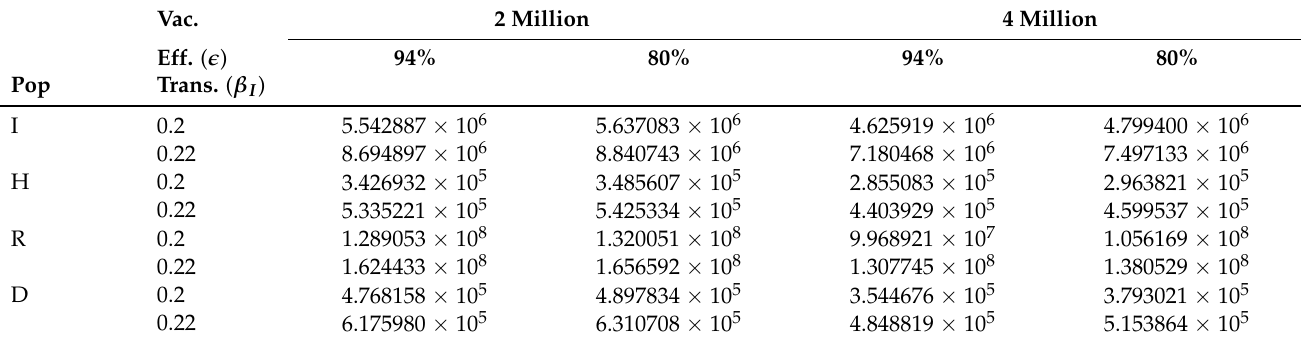
Table 5. Impact of the inoculation rate (Vac.) and the efficacy ( (cid:101) ) of the vaccine on the peak of the infected (I) and hospitalized (H) subpopulations. In addition, on the deaths (D) and recovered (R) cases. In these scenarios, the infectiousness of the asymptomatic individuals relative to symptomatic is 100% ( β A = β I ), and the percentage of infections that are asymptomatic is 40%.